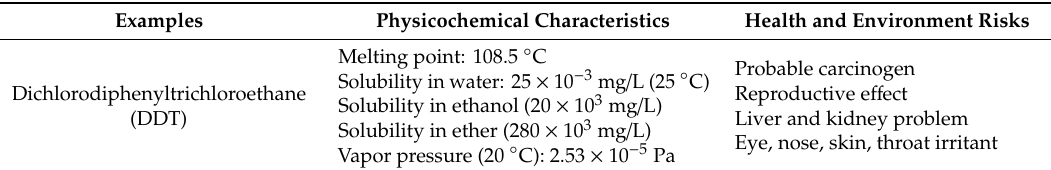
Table 1. Some examples of organochlorines pesticides, which are organic compounds with five or more chlorine atoms